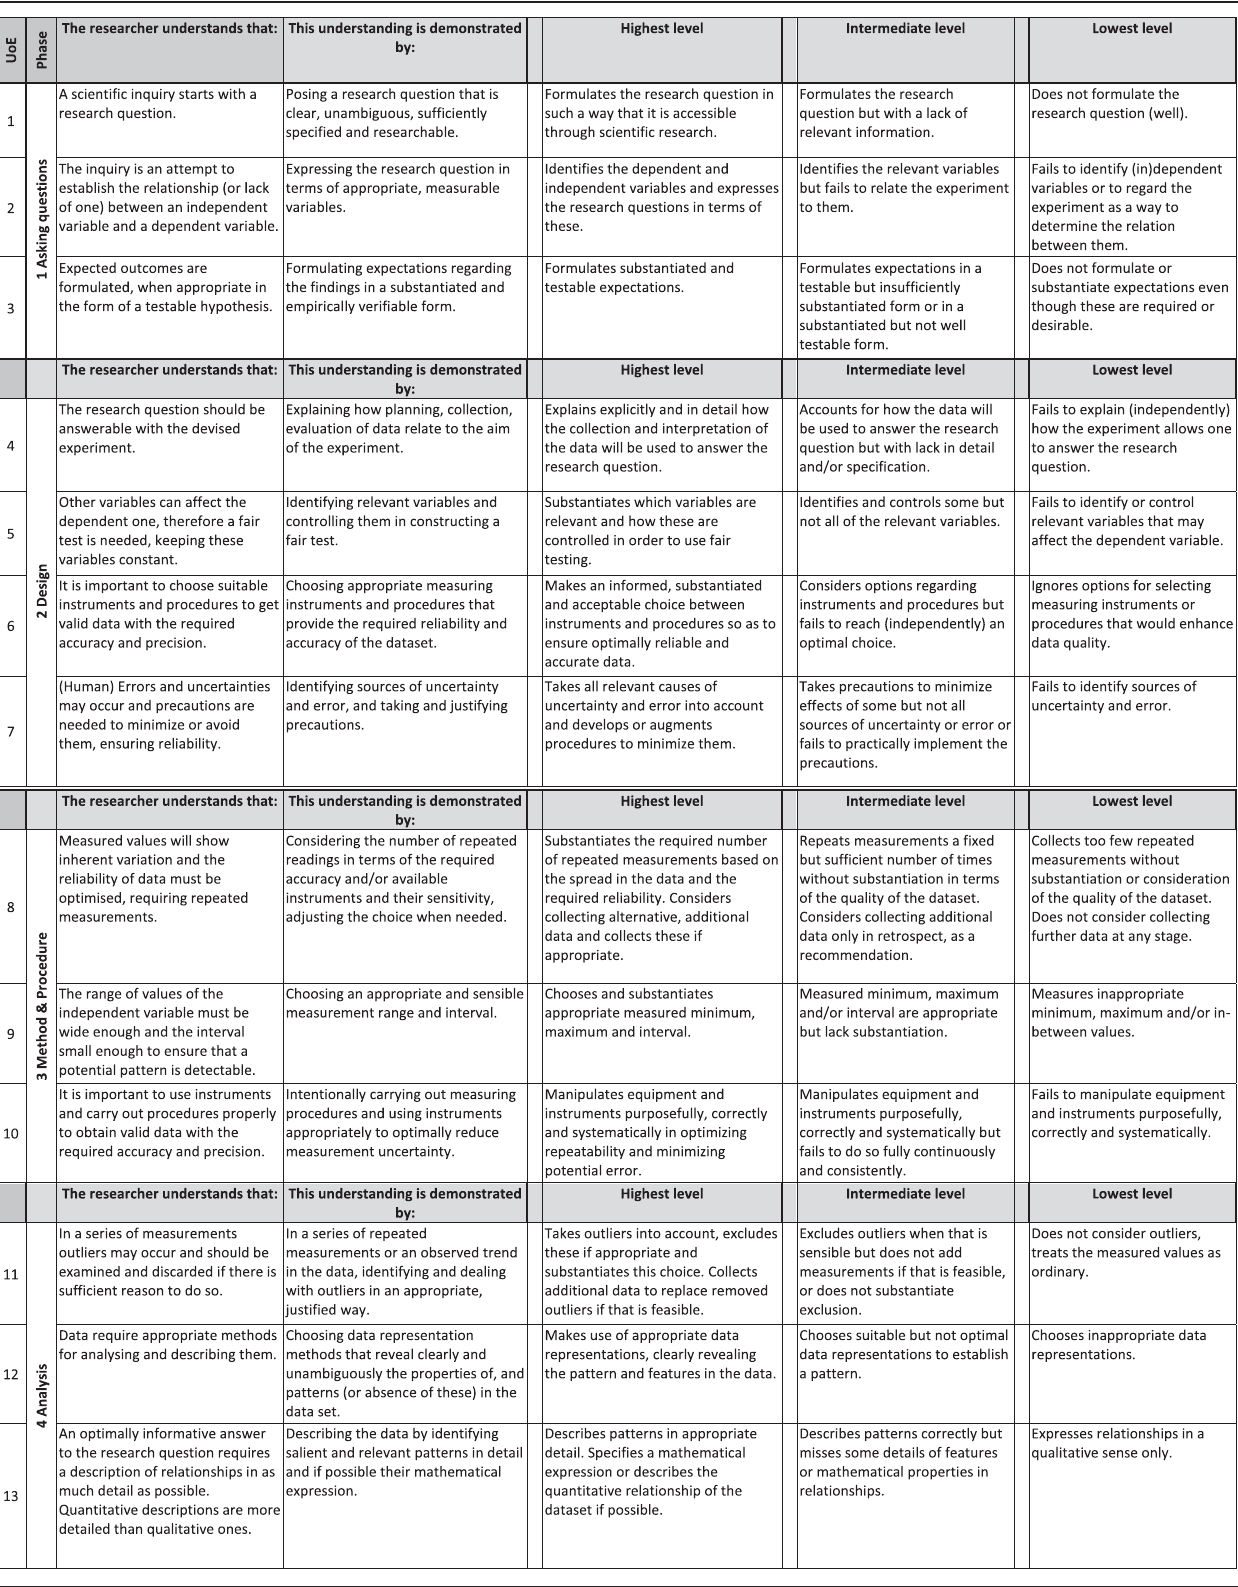
TABLE VI. ARPI consists of 19 understandings of evidence applied by a researcher when conducting a physics inquiry. Indicators for the lowest, intermediate and highest level are provided. Levels in between these are assigned when a student outperforms the lower level but has not fully attained the higher level. Table is available in excel